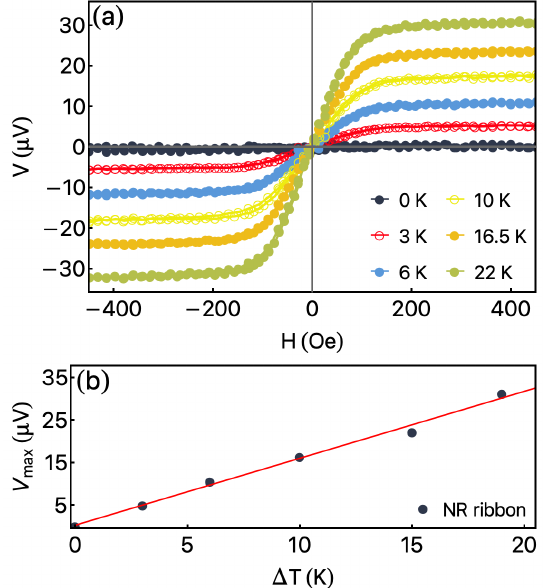
Figure 6. Anomalous Nernst Effect measurement for NR ribbon. ( a ) ANE voltage as a function of external magnetic field for distinct ∆ T values. ( b ) V max as a function of ∆ T for NR ribbon. From the slope of this curve, we estimated the S ANE value of our sample.